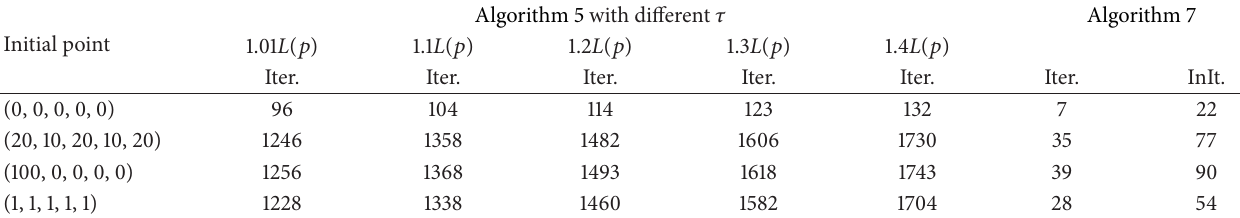
Table 1: Computational results for Example 13 with different algorithms.